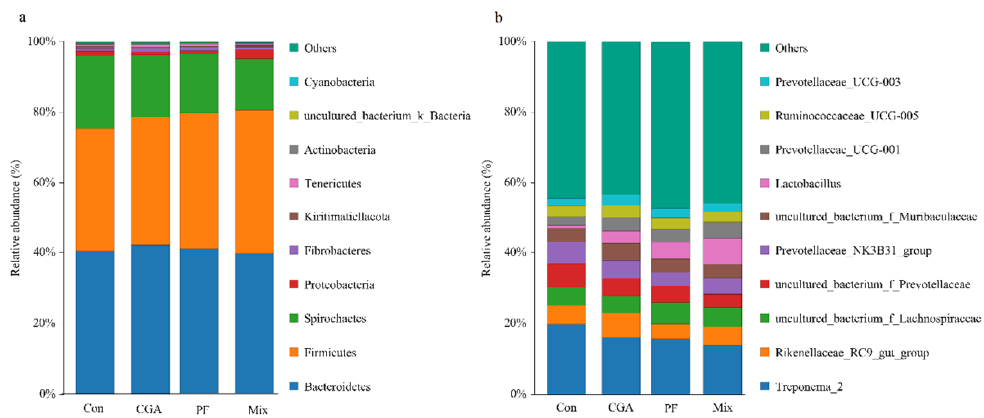
Figure 7. Annotation and taxonomic analysis of rectal species in finishing pigs. ( a ) Histogram of species distribution of phylum-level abundance ( b ) Histogram of species distribution of genus -level abundance. The horizontal coordinate is the sample name, and the vertical coordinate is the relative abundance (%). Table 3. Annotation and taxonomic analysis of rectal species in finishing pigs (phylum level).